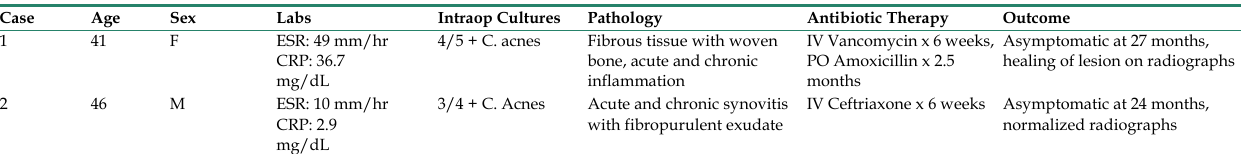
Table 1. Summary of cases at time of initial diagnosis Case Age Sex Labs Intraop Cultures Pathology Antibiotic Therapy Outcome 1 ESR: 49 mm/hr 2 46 M ESR: 10 mm/hr